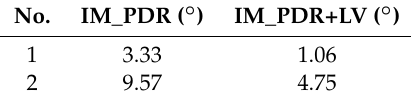
Table 5. Average heading errors of improved PDR and LV algorithm based on the improved